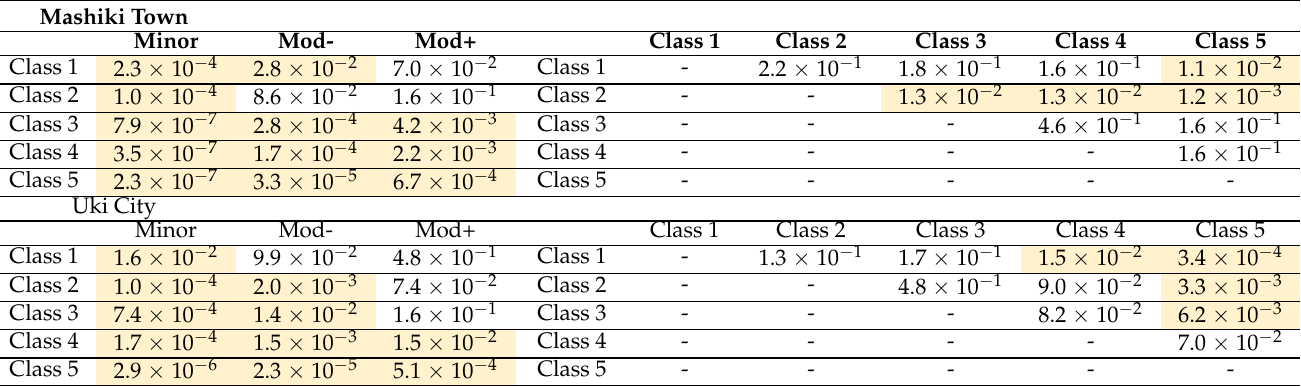
Table 5. Results of the significant difference test for γ dif between the damage classes (yellow indicates a significant difference was determined).